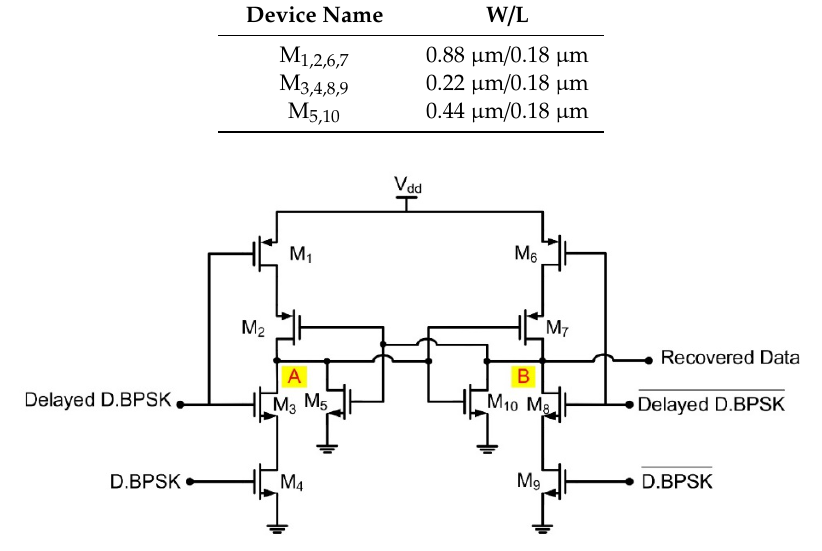
Table 1. Transistor dimensions of the data detector circuit.